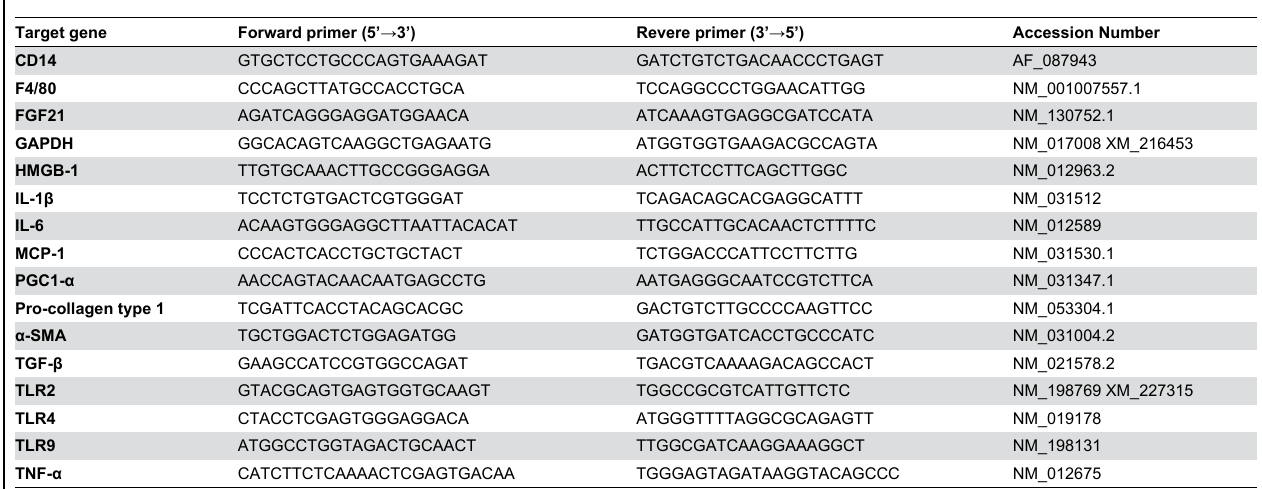
Table 2. Real-Time PCR Primer Sequences.